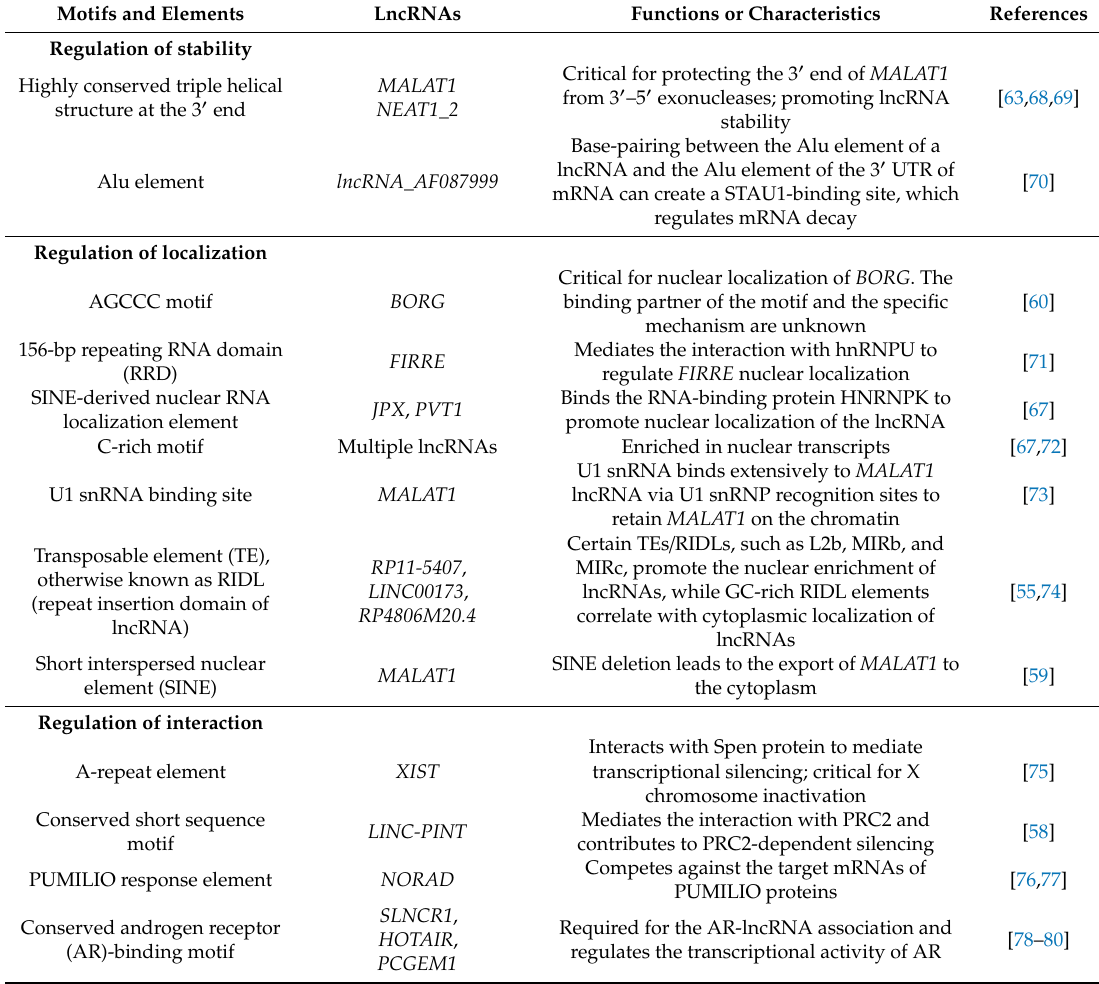
Table 1. List of long noncoding RNA (lncRNA) motifs and